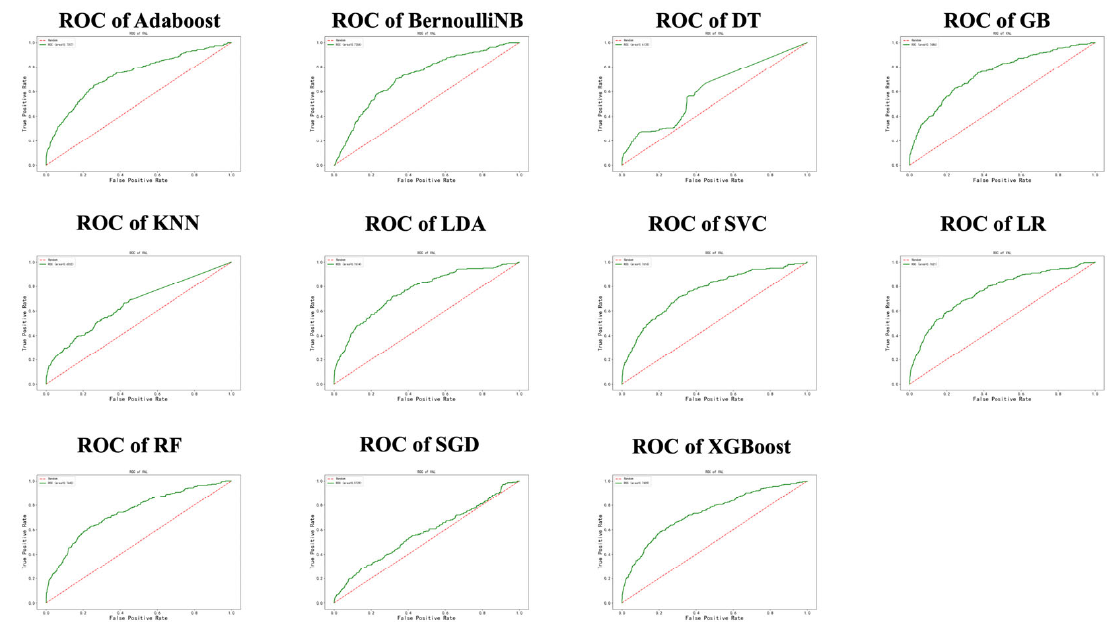
Figure 8. ROCs of ML prediction models in training cohort.